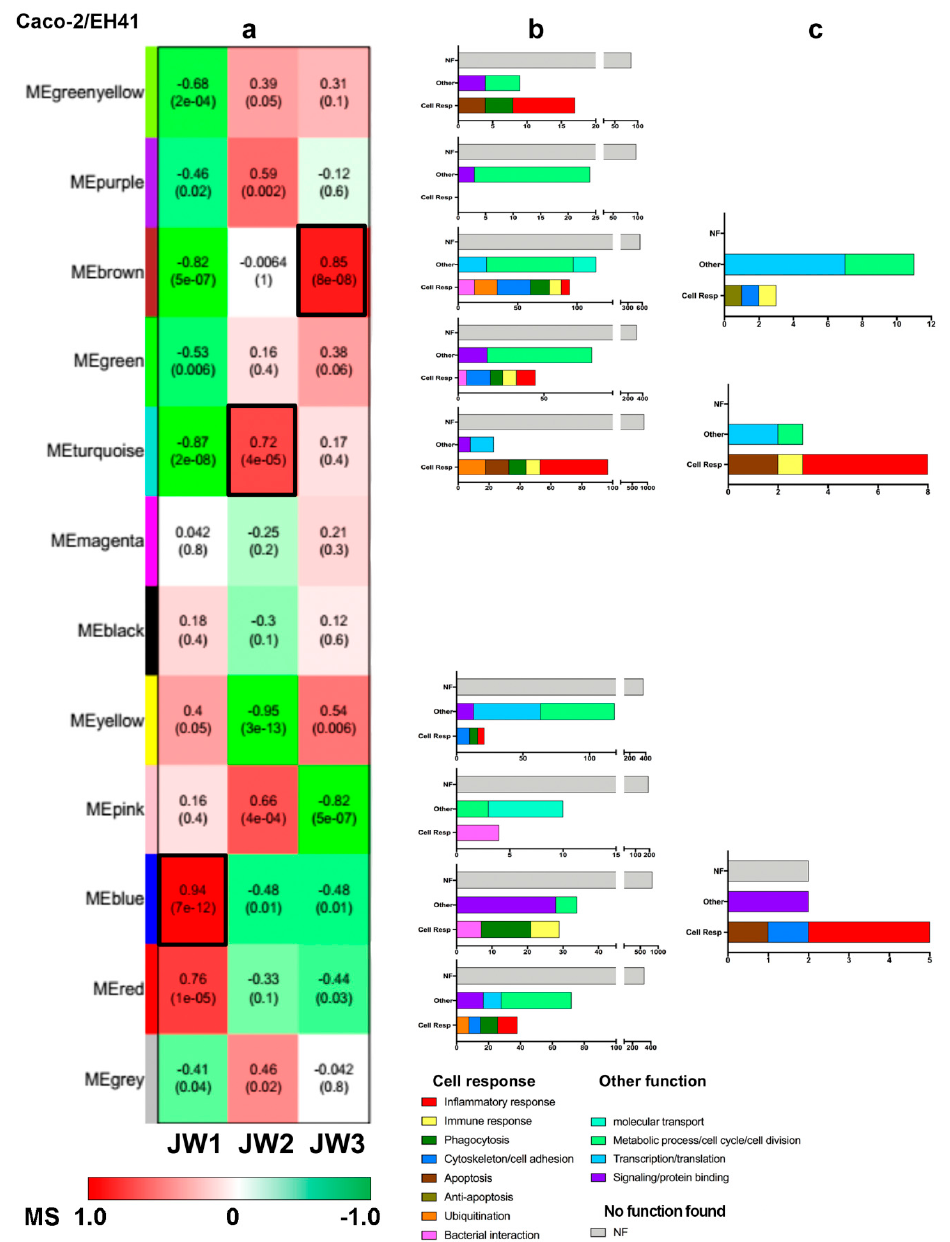
Figure 6. Module characterization of the Caco-2 / EH41 group. ( a ) Heatmap of the relationship between modules and the three temporal windows (JW1, JW2, and JW3). Color bar indicates the module significance (MS) value ranged from 1 to − 1. Numbers in the heatmap indicate a module correlation value and the numbers in parenthesis indicate p -values. The blue, turquoise, and black modules presented the highest association with JW1, JW2, and JW3, respectively. These modules are indicated by black borders. ( b ) KEGG enrichment analysis of the nine modules significantly associated with at least one window. ( c ) Functional profile of the hubs contained in the blue, turquoise, and black